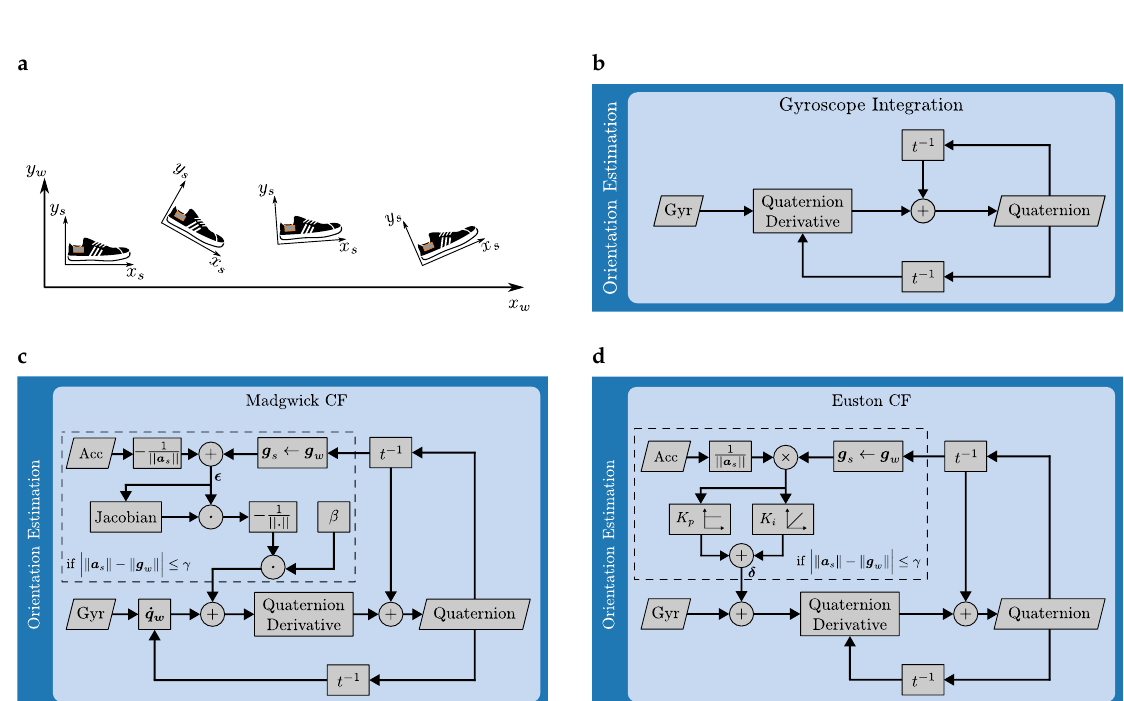
Figure 2. ( a ) Coordinate systems in the sagittal plane. Subscripts denote the sensor- and world-coordinate system; ( b – d ) Block diagrams for the three orientation estimation techniques implemented within this